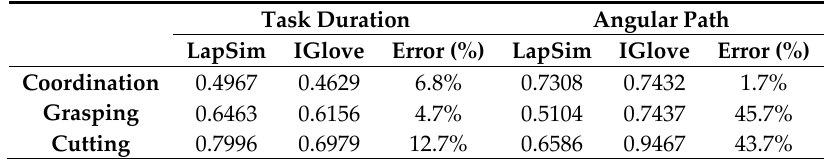
Table 1. Average ratios between first and last sessions (difference with LapSim